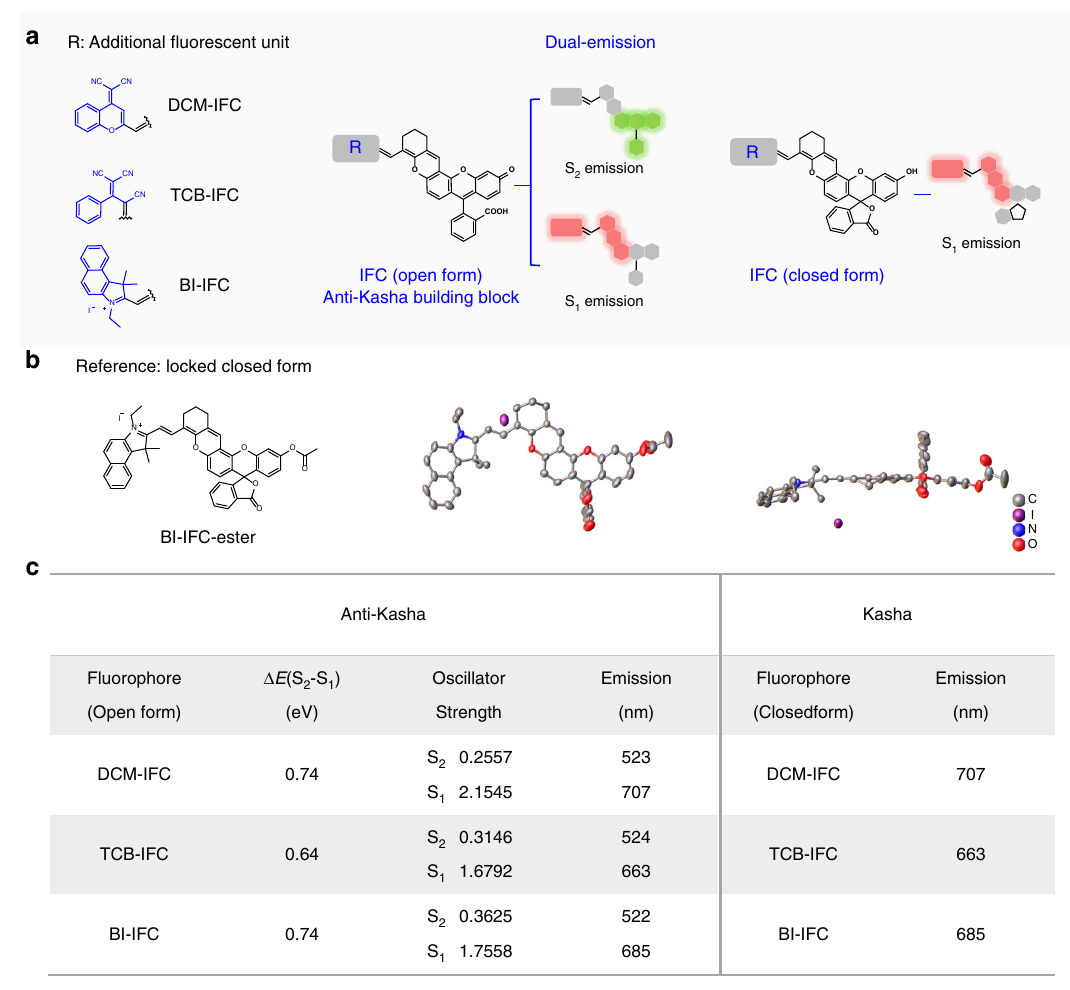
Fig. 3 A generalizable molecule engineering strategy for developing anti-Kasha/Kasha fl uorophores. a Schematic illustration of designing anti-Kasha/ Kasha fl uorophores. b Molecular and crystal structures of BI-IFC-ester (locked closed form). c Quantum chemical calculations and experimental data of anti-Kasha/Kasha fl uorophores. Δ E (S 2 − S 1 ) and oscillator strength were obtained from quantum chemical calculations. Emission was obtained from experimental